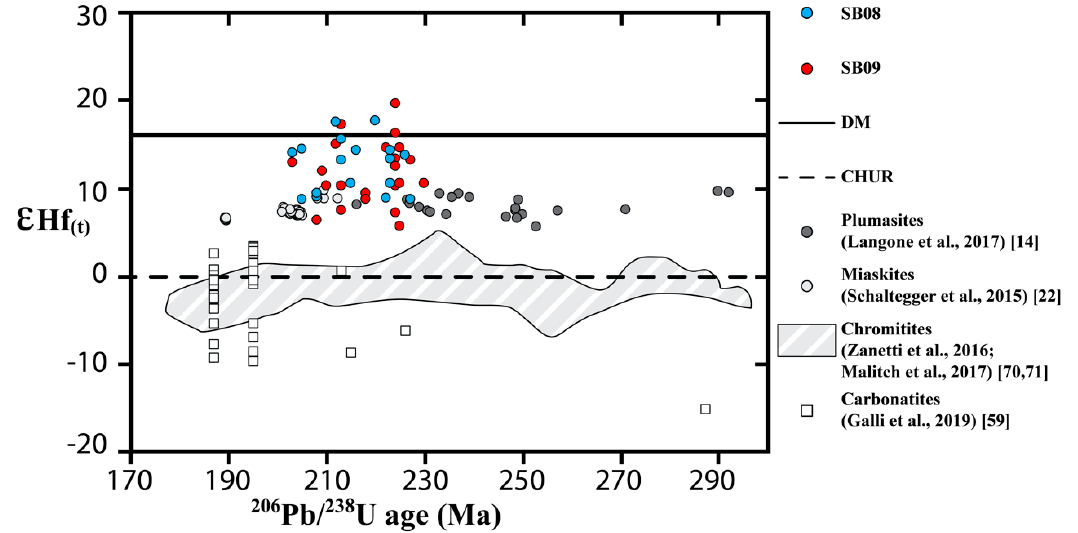
Figure 10. ε Hf (t) values from several magmatic bodies from IVZ. ε Hf (t) values are recalculated to the individual spot analysis 206 Pb/ 238 U ages.